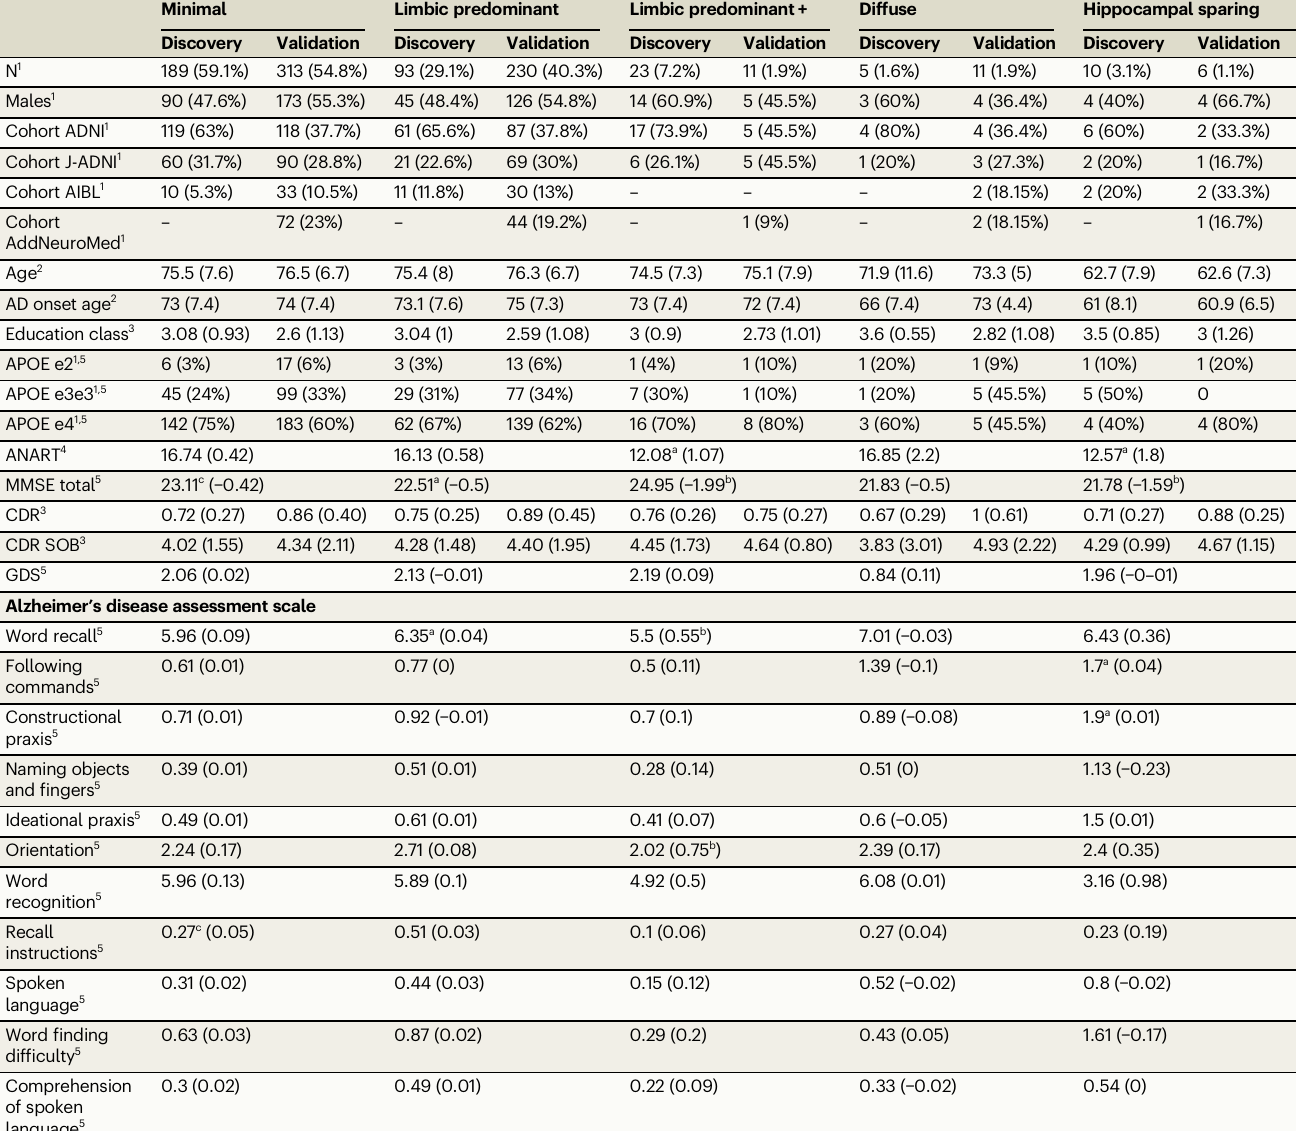
Table 3 | Cluster